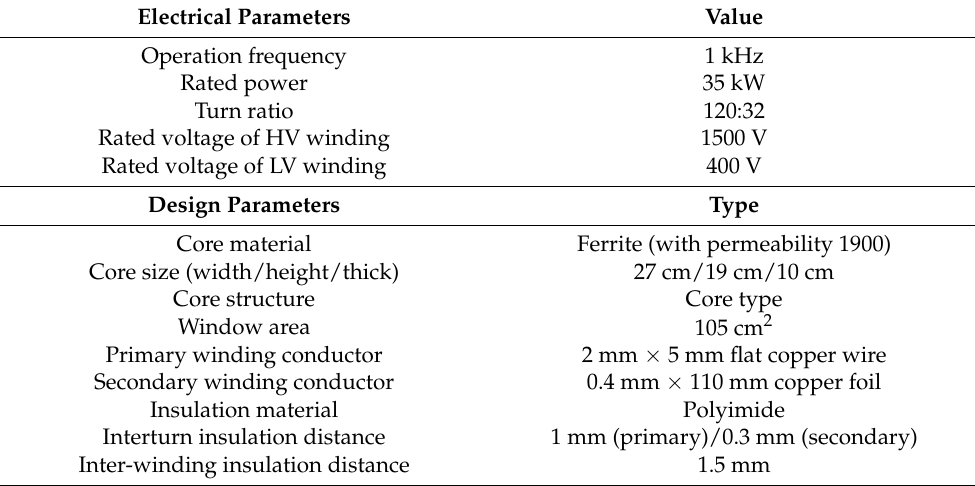
Table 2. Basic parameters of the transformer